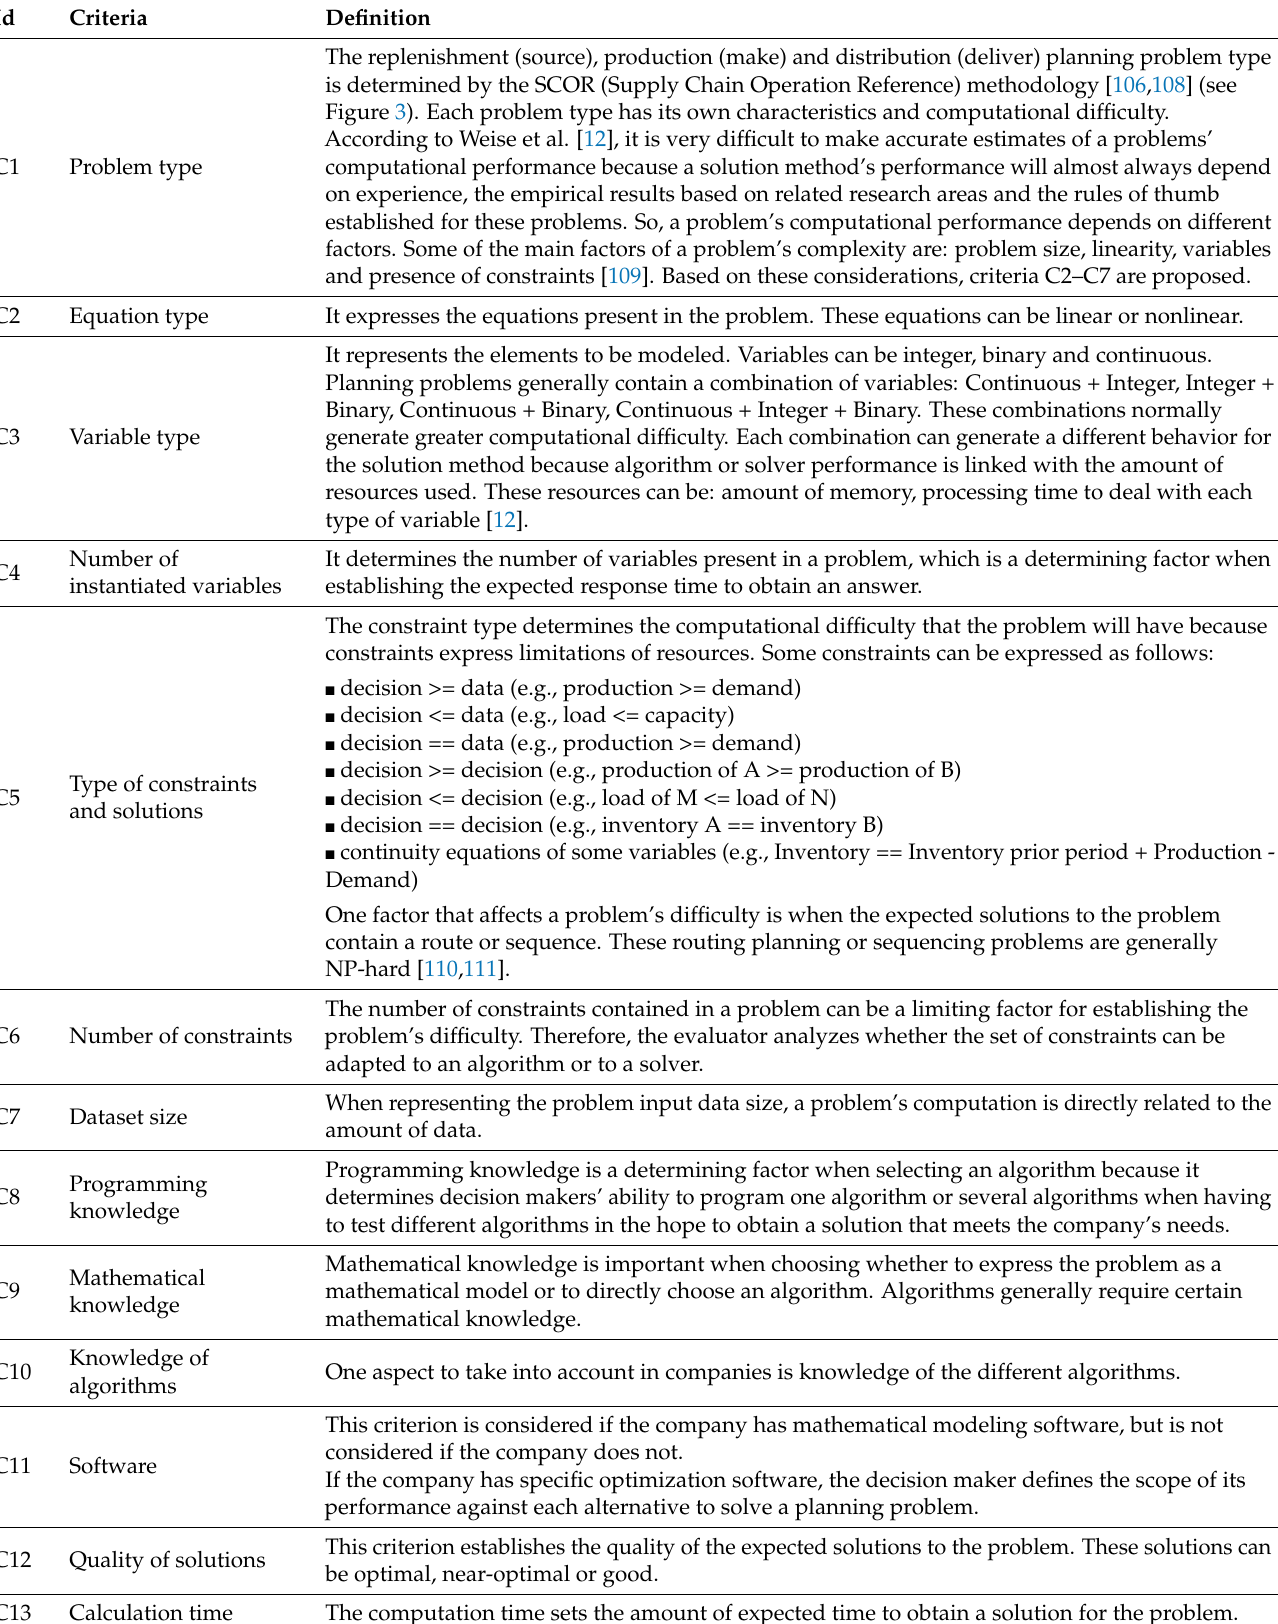
Table 2. Criteria for algorithm